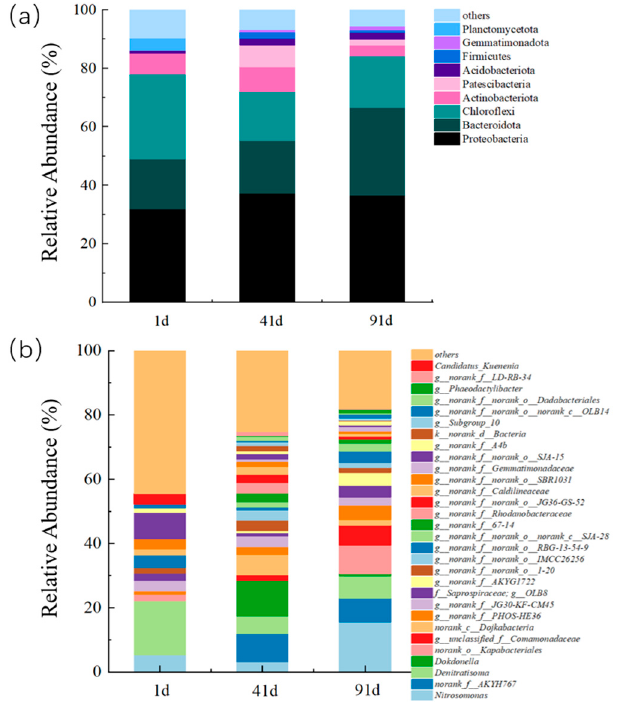
Figure 6. Composition of microorganisms at ( a ) phylum level; ( b ) genus level in ceramic MBR.